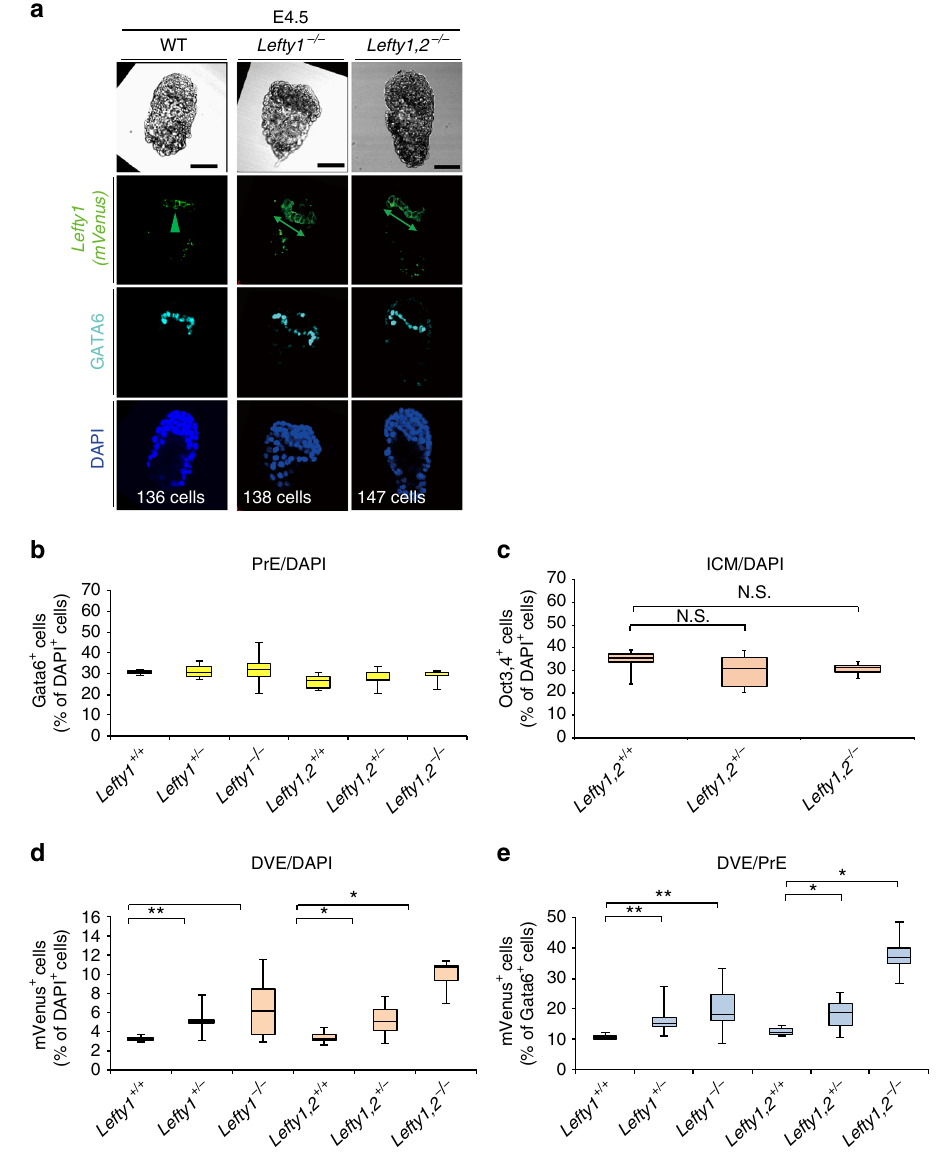
Fig. 4 Lefty1 and Lefty2 restrict the number of prospective DVE cells. a The number of prospective DVE cells [GATA6 + cells expressing the Lefty1(mVenus) BAC transgene] was examined in WT, Lefty1 – / – , and Lefty1,2 – / – embryos at E4.5. The embryos were subjected to immuno fl uorescence staining for mVenus and GATA6. Scale bars, 50 μ m. Arrowheads and double-headed arrows indicate mVenus + cells (prospective DVE cells). b – e Summary of the number of PrE cells (GATA6 + cells) as a percentage of total cells ( b ), the number of ICM cells positive for Oct3/4 staining as a percentage of total cells ( c ) (Supplementary Fig. 5c), the number of prospective DVE cells as a percentage of total cells ( d ), and the number of prospective DVE cells as a percentage of total PrE cells ( e ) in embryos of the indicated genotypes at E4.5. Data are presented as box-and-whisker plots ( fi rst and third quartile, the line represents the median; whiskers: minimum to maximum). * P < 0.05, ** P < 0.01; NS, not signi fi cant ( t